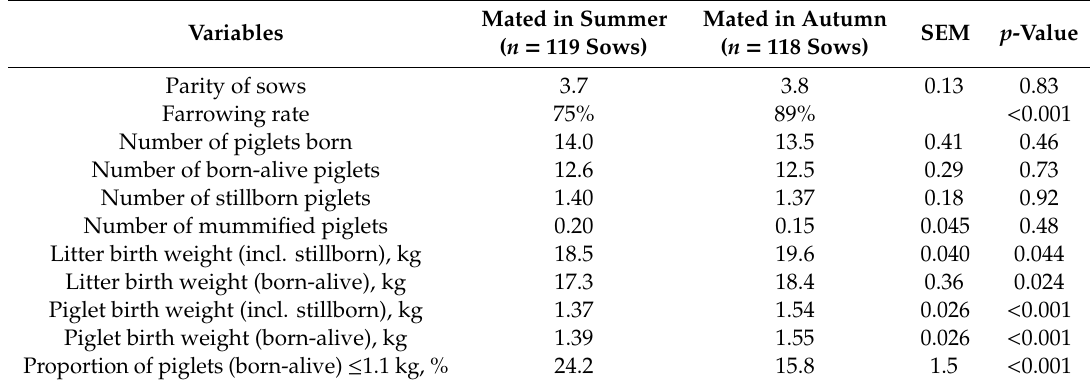
Table 2. Farrowing outcomes of sows mated in summer vs. autumn.